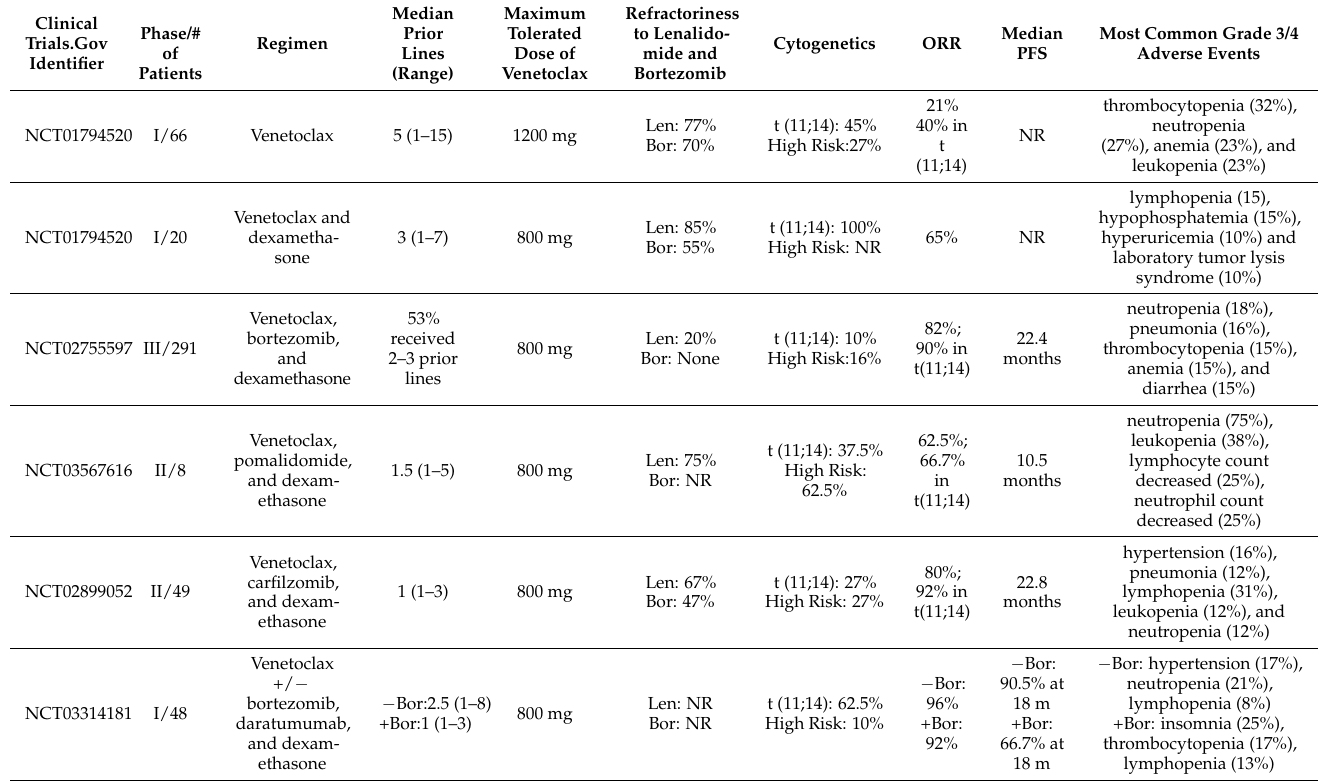
Table 2. Studies with venetoclax-based regimens in relapsed/refractory multiple